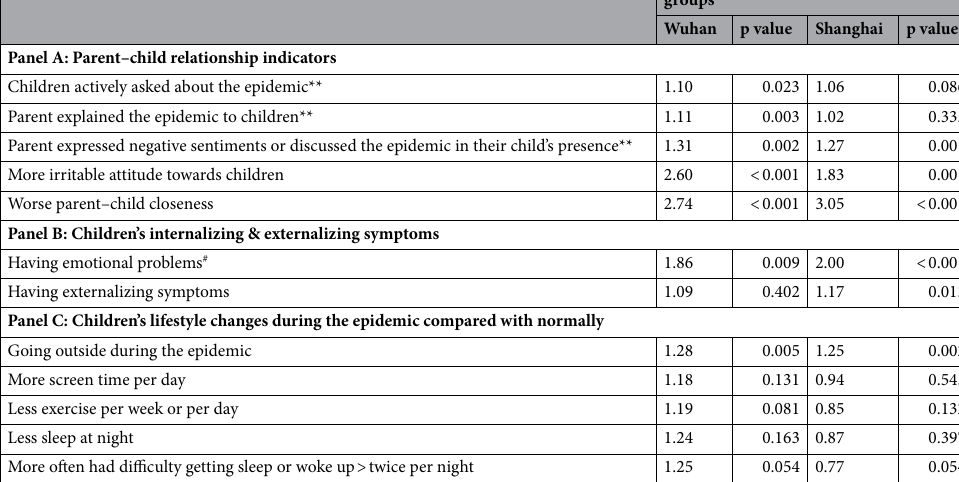
Table 3. Equity (ratio between the comparison groups) in parent–child relationships, children’s internalizing and externalizing symptoms, and lifestyle changes during the COVID-19 epidemic. *Ratios generated by dividing the proportion of the group without bachelor degree by the group with bachelor or above. The ratios indicate the gap between the comparison group—where 1 implies no gap, and p value are from Chi square or fisher’s exact tests (when applicable). **This is “Yes” category which includes response options of “always,” “usually,” and “sometimes” for three questions on the frequencies of parent–child communications about the COVID-19 epidemic. # One’s SDQ-Emotional Symptoms Score ≥ 5 for parent version or ≥ 7 for child version was considered to have substantial risk of clinically significant emotional problems (in short, having emotional